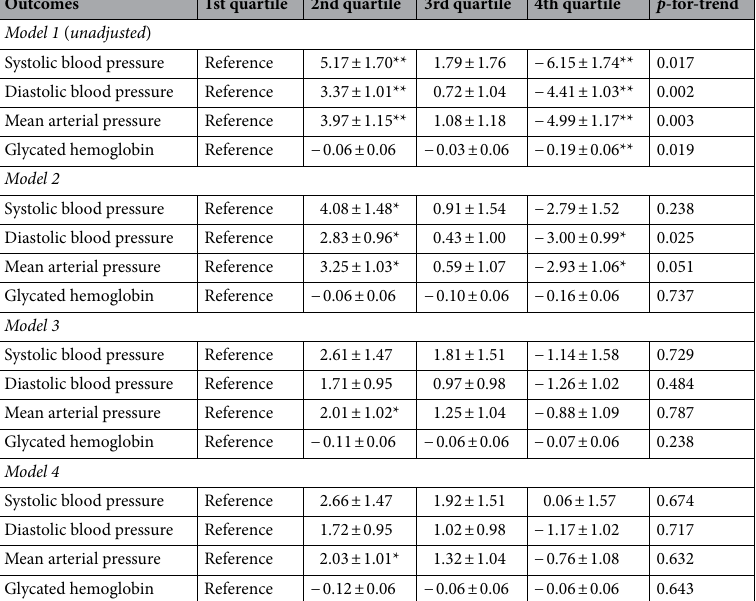
Compared to lower consumption (1st quartile), higher consumption (4th quartile) was characterized by a higher frequency of women (58.1 vs. 81.2%, respectively), lower BMI (28.4 vs. 24.9 kg/m 2 , respectively), higher total energy intake (2205.6 vs. 2667.4 kcal/day, respectively) and lower frequency of hypertension (24.1 vs. 14.7%, respectively). Regarding blood pressure parameters, individuals classified as higher egg consumers presented lower SBP, DBP and MAP than those who consumed fewer eggs per kg of BW ( p < 0.001). These same blood pressure parameters were higher in the 2nd quartile than in the 1st, 3rd and 4th quartiles. Finally, HbA1c levels were significantly lower ( p = 0.014) in participants in the 4th quartile (5.38%) than in those in the 1st quartile (5.56%) of egg consumption (Table 1). The correlation analyses presented in Table 2 showed that egg consumption was inversely associated with SBP ( r = − 0.092), DBP ( r = − 0.120), MAP ( r = − 0.116) and HbA1c ( r = − 0.090). Unadjusted linear regression (Model 1) comparing higher versus lower consumption (i.e., 4th vs. 1st quar- tiles) showed that the higher the consumption of eggs, the lower the SBP (ß = − 6.15 ± 1.74; p -for-trend = 0. 017) and DBP (ß = − 4.41 ± 1.03; p -for-trend = 0.002), MAP (ß = − 4.99 ± 1.17; p -for-trend = 0.003) and HbA1c (ß = − 0.19 ± 0.06; p -for-trend = 0.019) (Table 3). The associations between egg consumption and DBP and mean